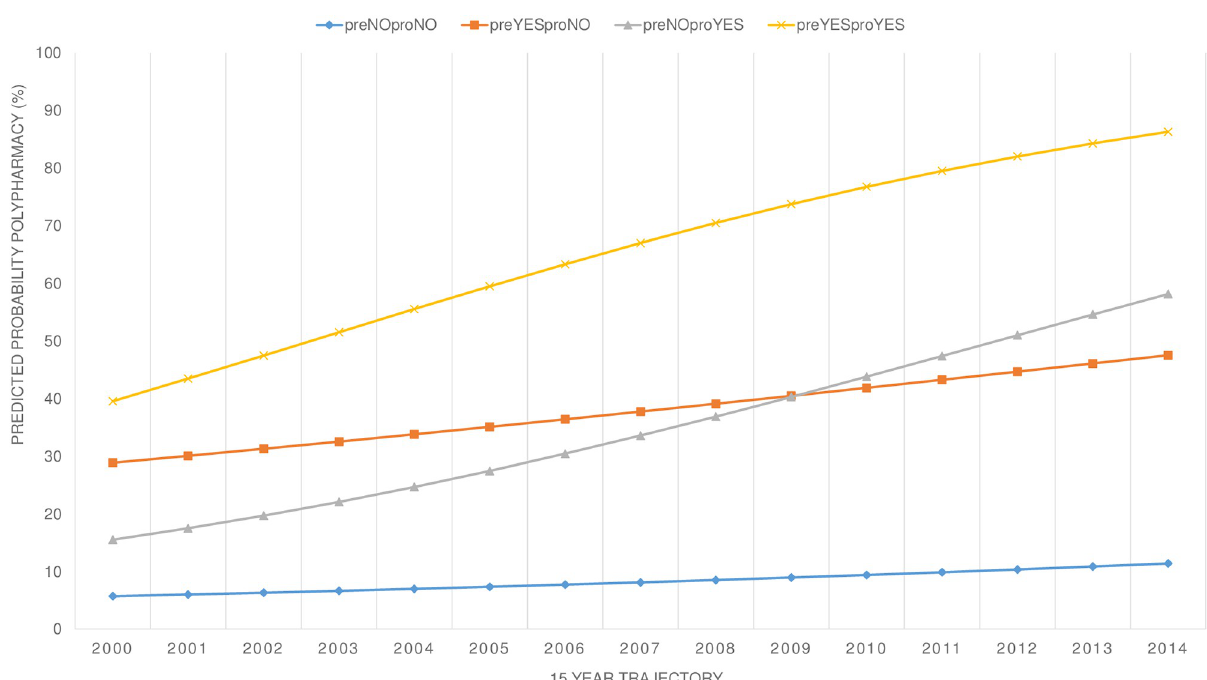
Fig 6. Predicted probability of polypharmacy stratified by presence of multimorbidity at baseline (pre) in combination with emergence of incident multimorbidity during 15-year trajectory (pro).